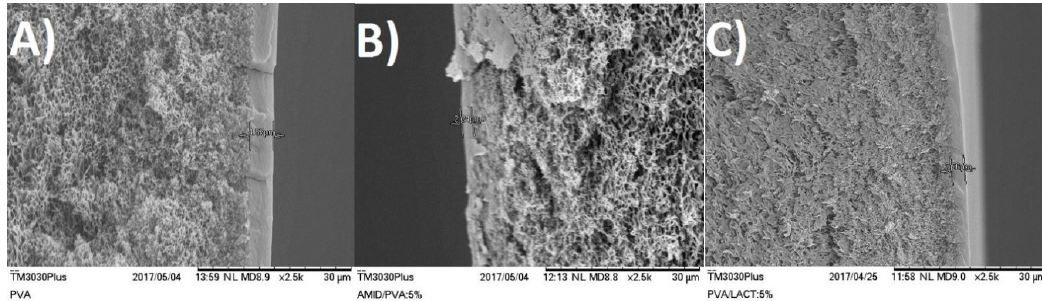
Figure 2. SEM-SE cross section pictures from the PSf support flat sheet membranes ( A ) PVA; ( B ) Amidino POSS ® /PVA:5%; ( C ) Lactamide POSS ® /PVA: 5%.